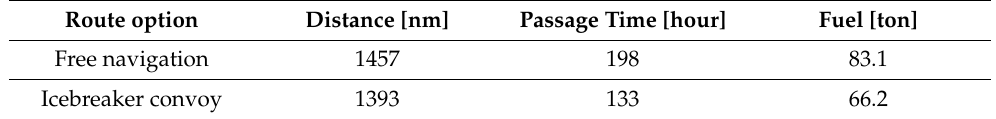
Table 5. Comparison between routes with and without icebreaker assistance. Route